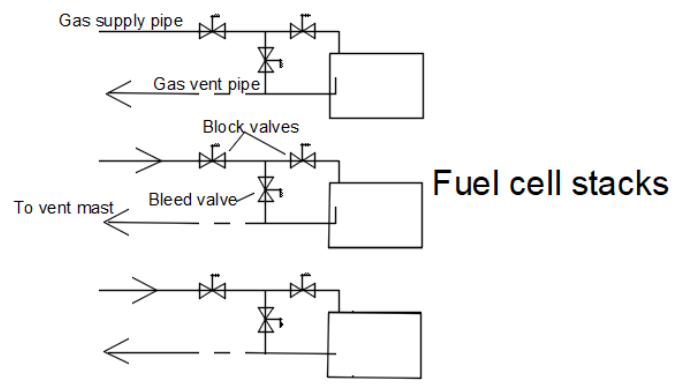
Figure 2. Gas and vent piping in the fuel cell room.